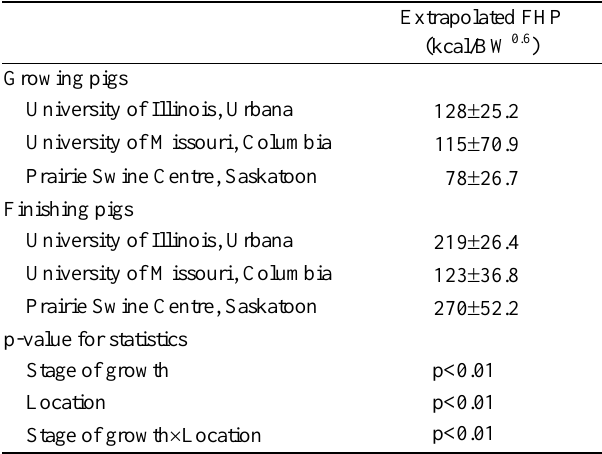
Table 2. Effects of stage of growth and experimental locations on extrapolated fasting heat production (FHP) of pigs 1